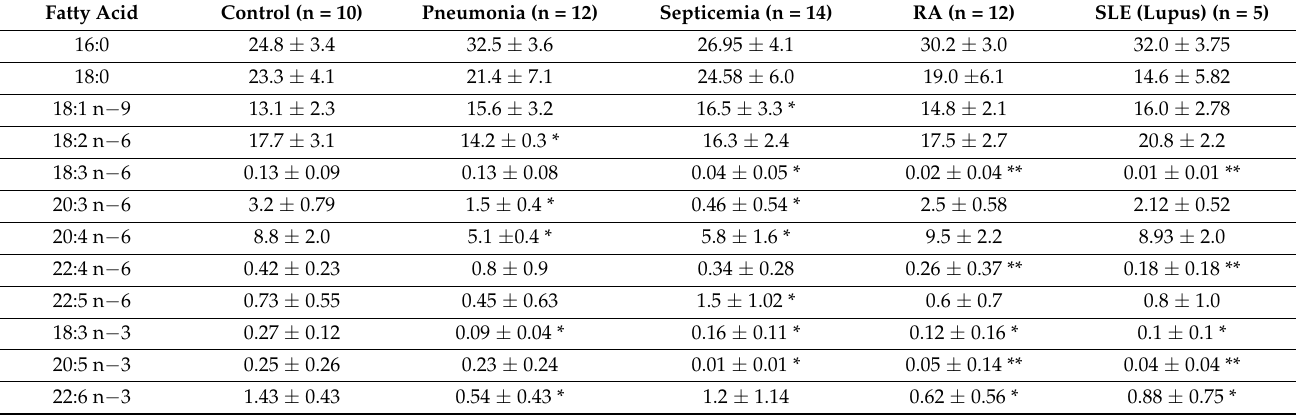
Table 3. Fatty acid analysis of the plasma PL (phospholipid) fraction in patients with pneumonia, septicemia, RA and lupus. Both pneumonia and sepsis are more common elderly. All values are expressed as mean ± S. E. This data is taken form [106]. ** p < 0.001 compared to control; * p < 0.05 compared to